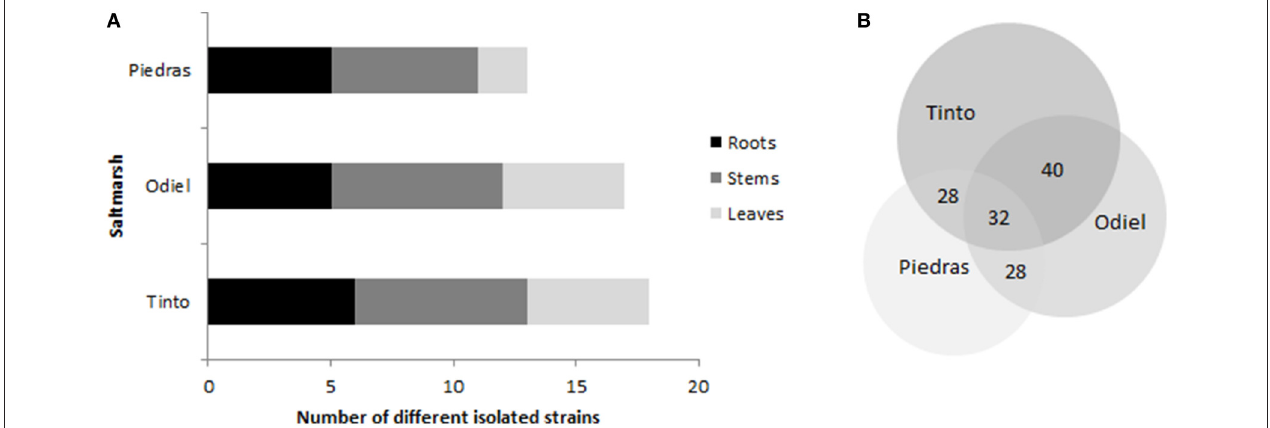
FIGURE 2 | Chart illustrating (A) cultivable endophytes location within distinct plant tissues in each estuary and (B) cultivable endophytes distribution according to the salt marshes expressed as a percentage of total strains isolated (25).